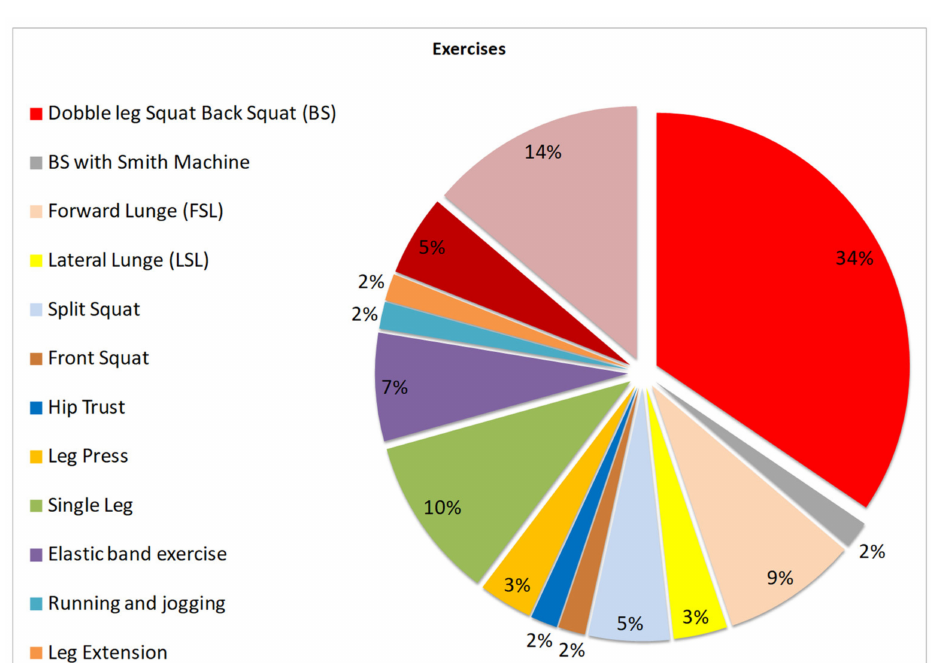
Figure 2. Types of exercise studied in the selected